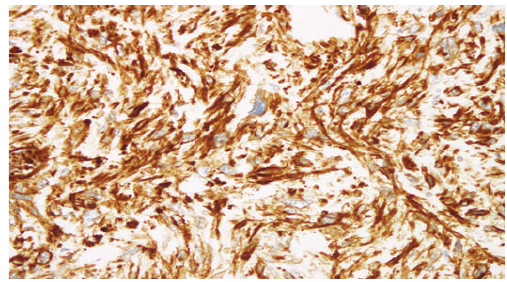
Figure 4: The tumor cells are strongly positive for desmin immuno- histochemistry. Desmin